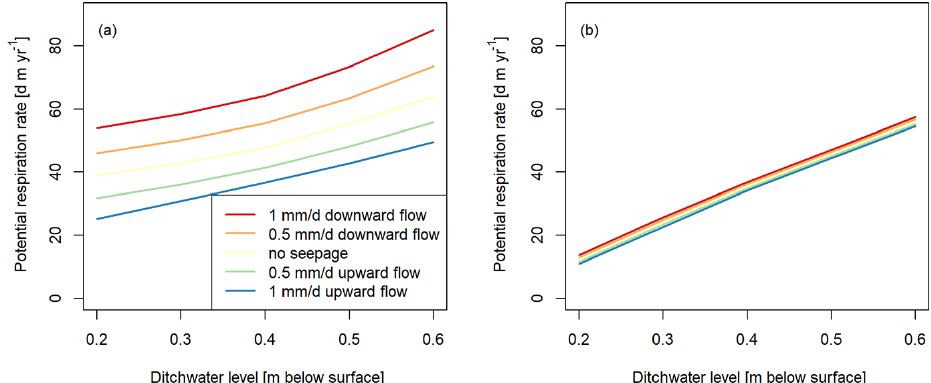
Figure 9. (a) The simulated effects of ditchwater level on potential respiration rate for different seepage settings within a control scenario and (b) these effects with SSI in the dry year 2018. The colours of the lines represent the model seepage setting.